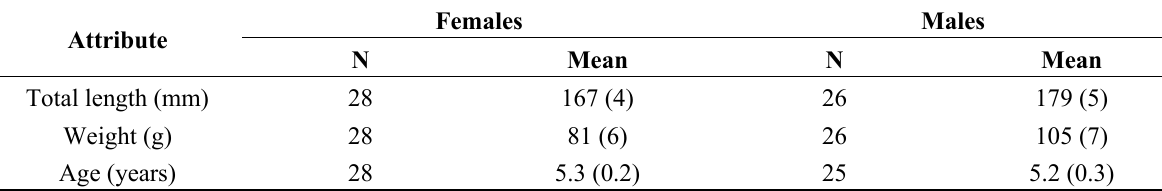
Table 1. Mean (standard error of the mean enclosed within parentheses) for total length, weight, and age of adult bluegills, by sex, caught in Squaw Lake (Oakland County, MI, USA) during May